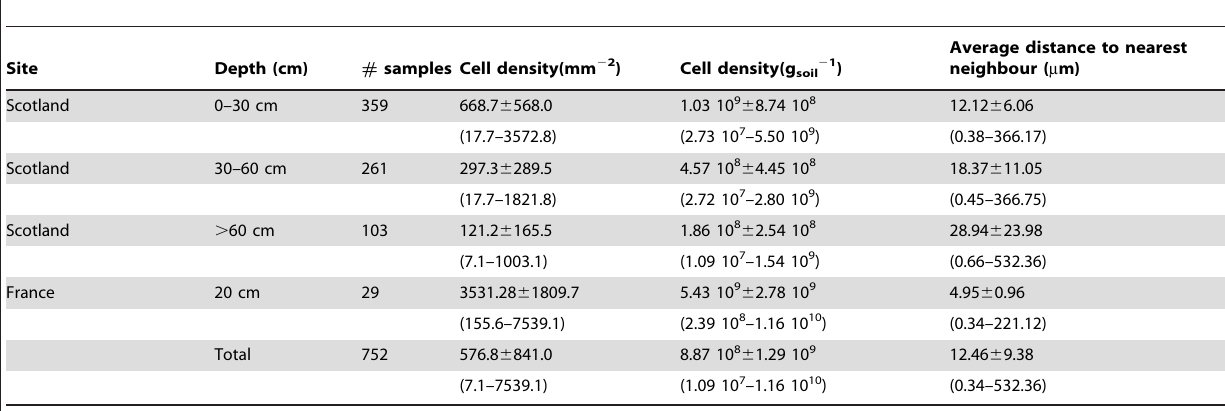
Table 1. General properties of all observed distribution maps of bacteria at different depths in soil.